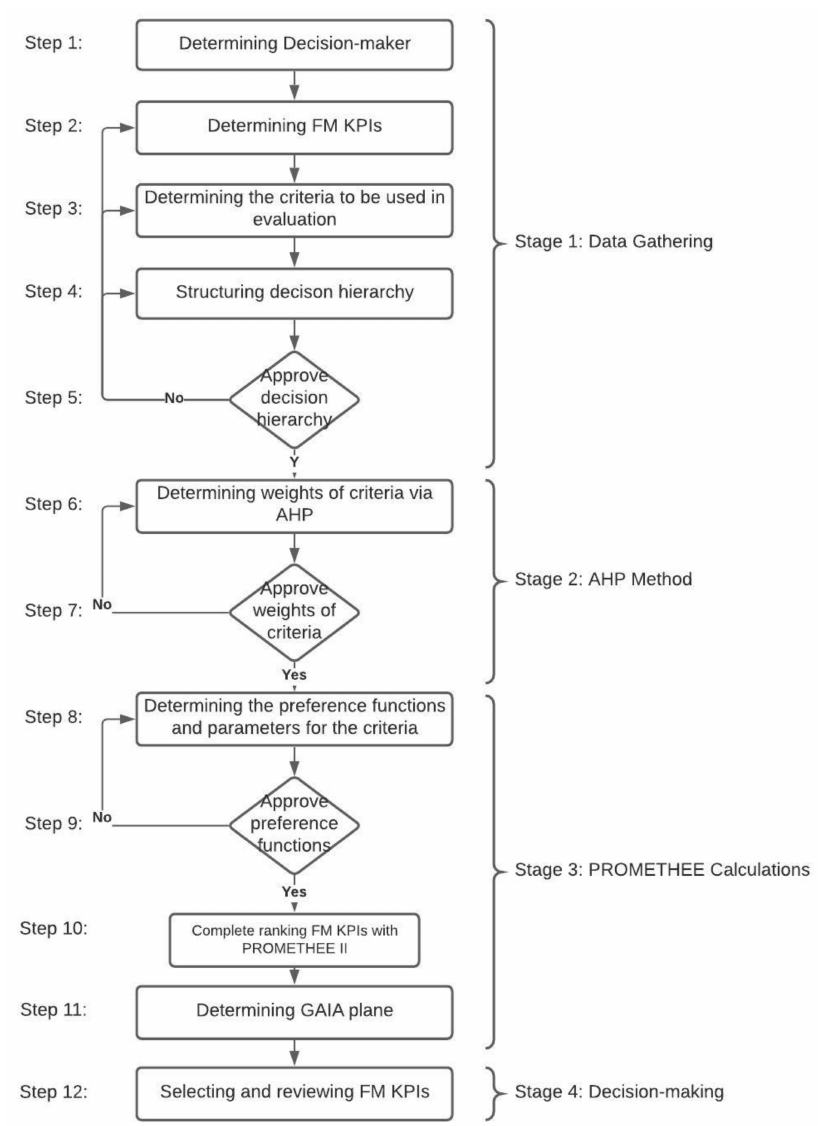
Figure 2. The research process plan for the determination of FM KPIs (adapted from